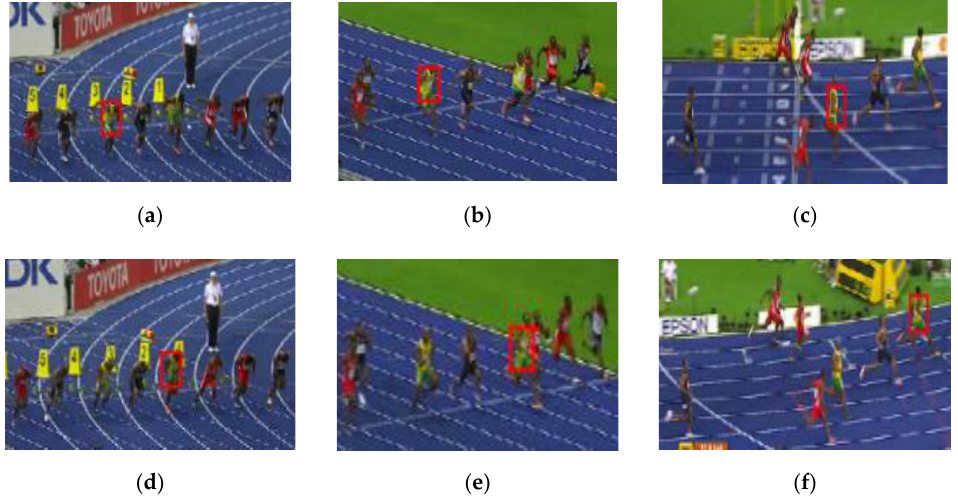
Figure 12. Comparison of original SiamFC and our ModReLU–Gaussian low pass filter-based SiamFC in scene “Bolt 1”: ( a – c ) Snapshots from original SiamFC (Precision: 3.43, AUPC: 1.12, IOU: 2.16,